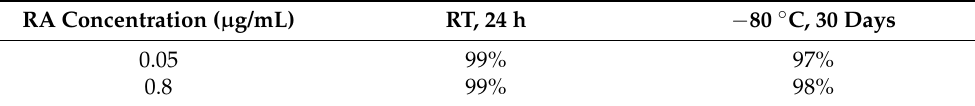
Table 1. Percentages remaining of RA in TL extracts for short ‐ term (stored at room temperature for